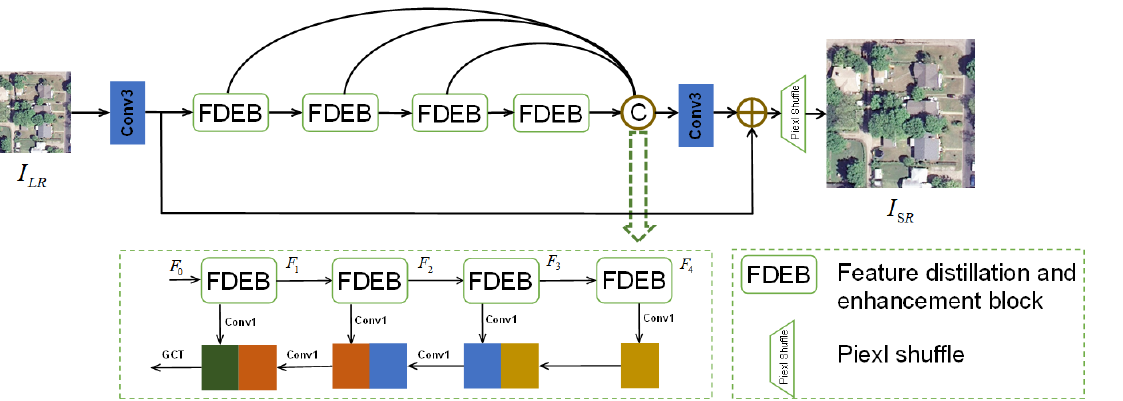
Figure 1. The overall network architecture of the proposed FDENet. The content in the green box represents the backward fusion module; represents the element-wise ⊕